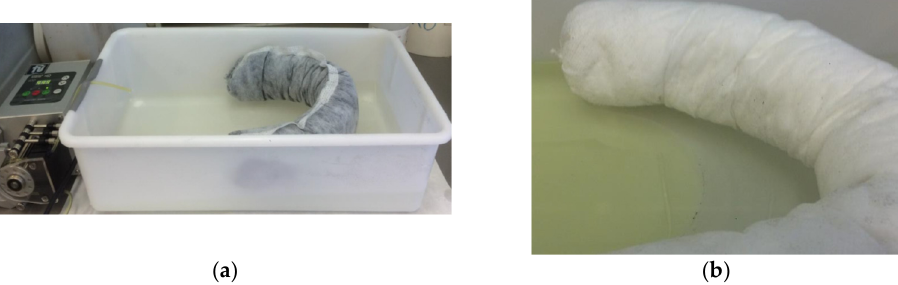
Figure 7. Experimental device for containment tests: ( a ) with a Grafysorber ® G+ boom; ( b ) with a PP boom.